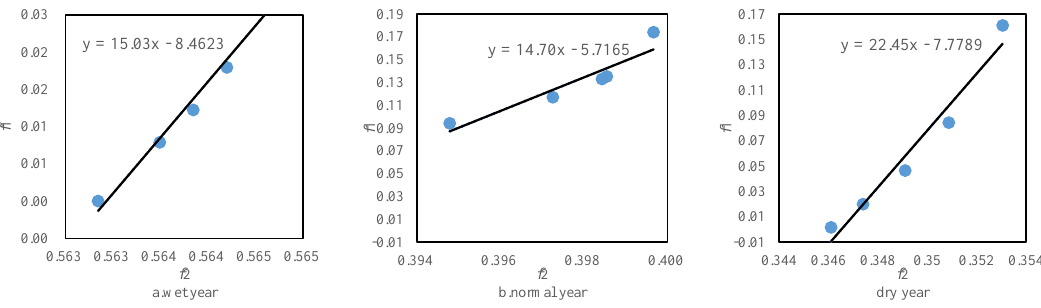
Figure 13. Correlation between power generation and ecological elasticity in each typical year.